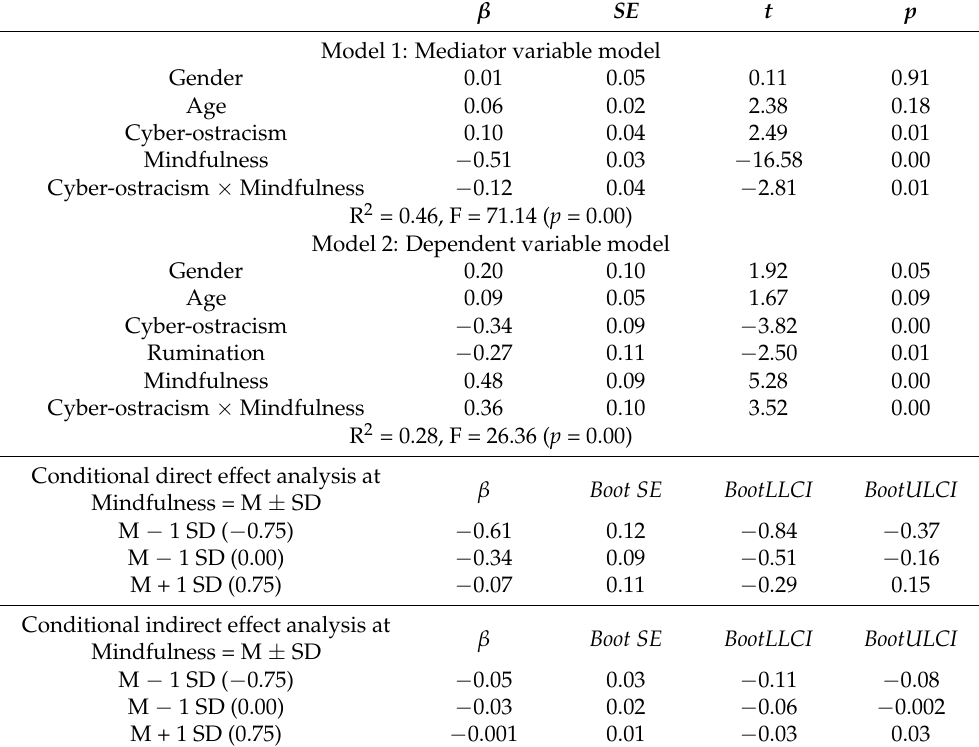
Table 3. Examining the moderated mediation effect of cyber-ostracism on psychological well-being. β SE t p Model 1: Mediator variable